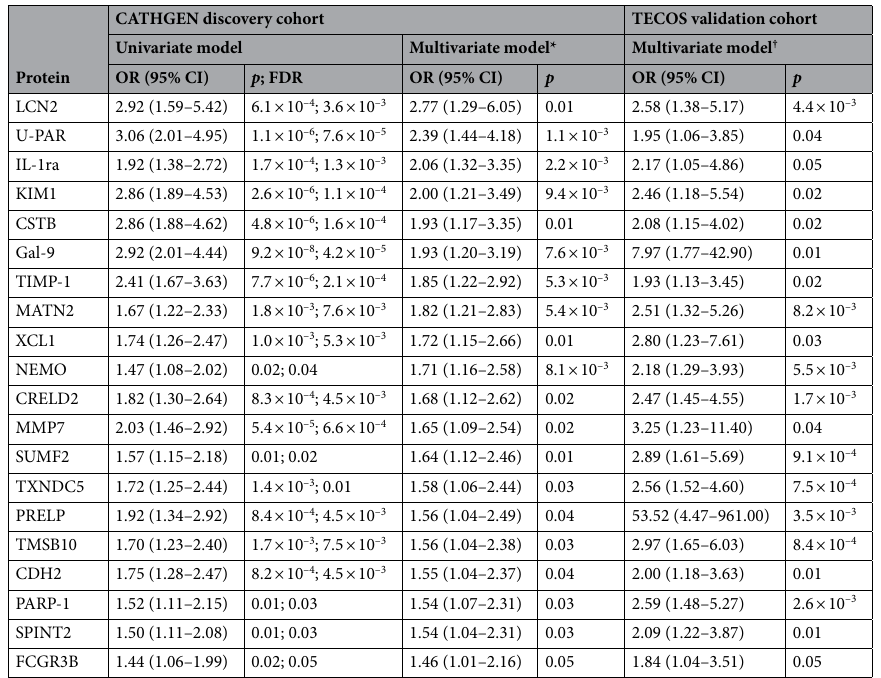
Table 2. Proteins associated with HFpEF in both discovery CATHGEN and validation TECOS multivariate models. *CATHGEN multivariate models includes age, race, sex, body mass index (BMI), systolic blood pressure (SBP), type 2 diabetes mellitus (DM) and creatinine. † TECOS multivariate model includes the same covariates except